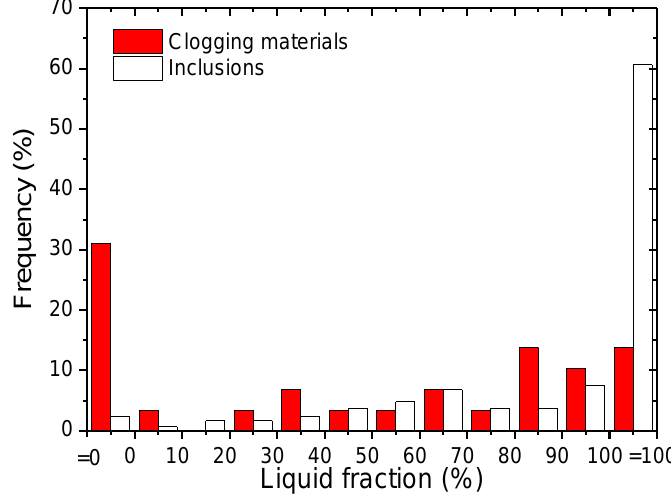
Figure 8. Frequency of the liquid fraction of clogging materials of the SEN and inclusions in the steel.